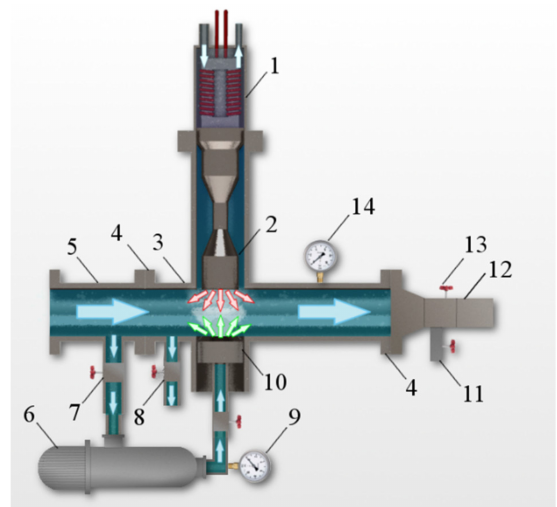
Figure 1. Cavitational device for disinfection of deionized water in dynamics. (1)